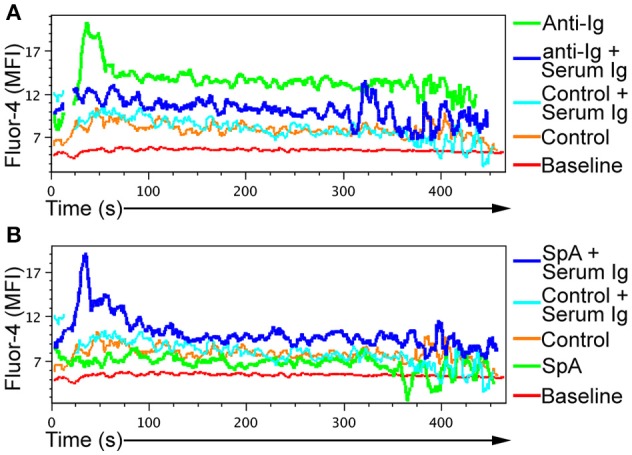
Induction of BCR-mediated in vitro B-cell activation by SpA requires soluble immunoglobulin. Splenic B cells from T15i mice were loaded with Fluor-4 dye, and calcium flux measured over time via flow cytometry. Cells were stimulated with either (A) goat Fab'2 anti-mouse Ig (H+L) (anti-Ig) or (B) soluble recombinant SpA, in the in the presence or absence of serum immunoglobulin (Ig), as indicated. For control conditions, cells were incubated in the absence of anti-Ig or SpA or soluble Ig. Assays results were repeated at least twice.